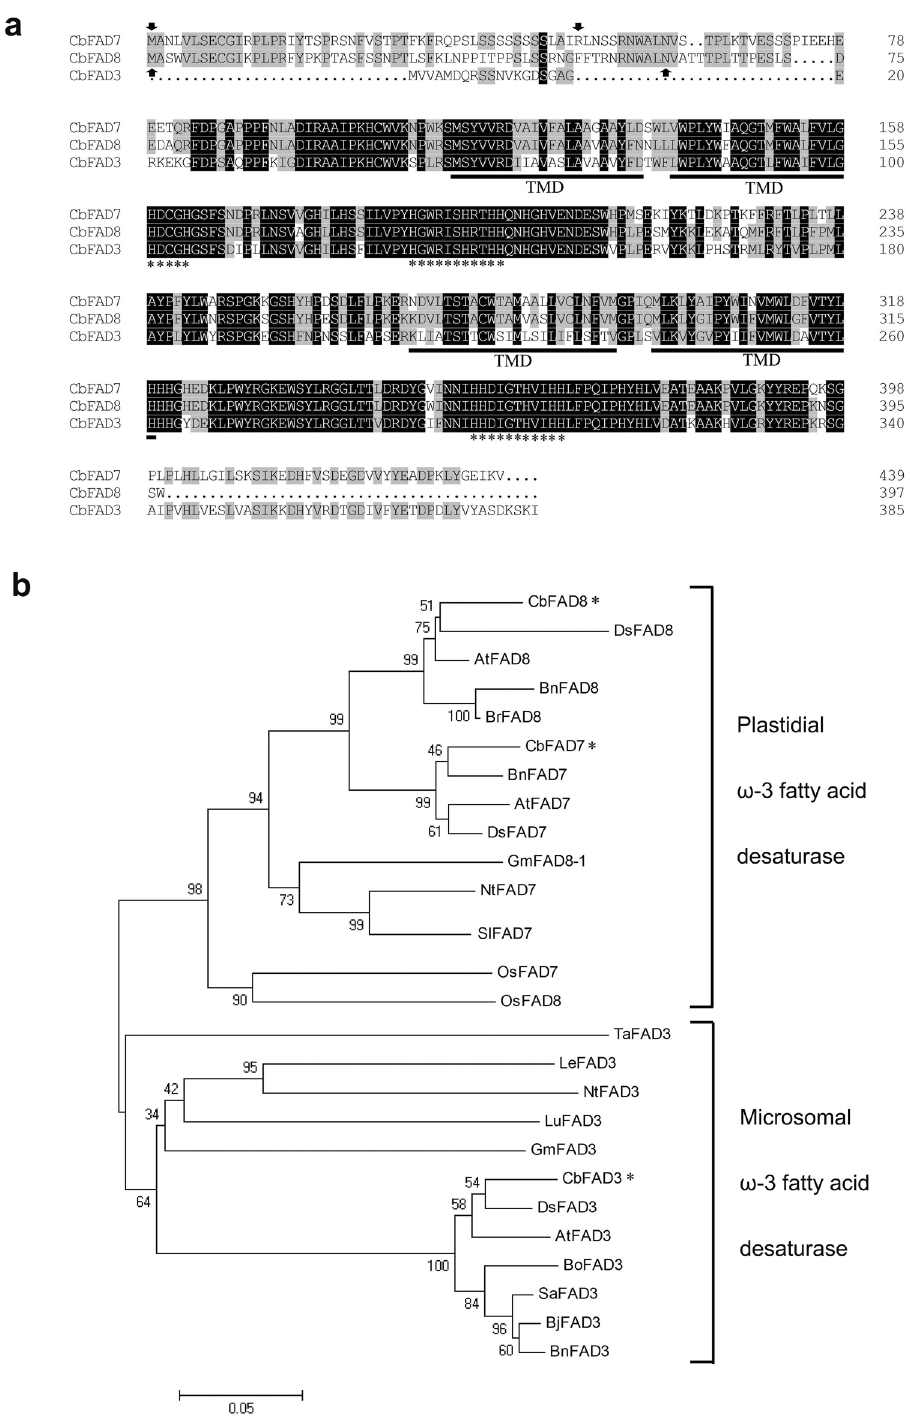
Figure 1. Analysis of the deduced amino acid sequences of C. bungeana ω-3 FADs. ( a ) Sequence comparison of CbFAD3, CbFAD7 and CbFAD8. Identical and similar residues are shown on a background of black and gray, respectively. The sequences of the putative chloroplast transit peptides of CbFAD7 and CbFAD8 are arrowed. The three conserved histidine clusters are indicated by asterisks, and the four transmembrane domains (TMD) are underlined. ( b ) Phylogenetic tree analysis of CbFAD3, CbFAD7 and CbFAD8. The positions of ω-3 CbFADs are asterisked. The accession number of different ω-3 FADs included in this analysis: Arabidopsis thaliana AtFAD3 (NP180559), Brassica juncea BjFAD3 (ADJ58019), Brassica napus BnFAD3 (NP001302640), Brassica oleracea BoFAD3 (AGH20189), Chorispora bungeana CbFAD3 (KM591203), Chorispora bungeana CbFAD7 (KY069282), Chorispora bungeana CbFAD8 (KY069283), Descurainia sophia DsFAD3 (ABK91879), Glycine max GmFAD3 (NP001237507), Lycopersicon esculentum LeFAD3 (ABX24525), Linum usitatissimum LuFAD3 (AFJ53089), Nicotiana tabacum NtFAD3 (P48626), Sinapis alba SaFAD3 (AHA05997), Triticum aestivum TaFAD3 (BAA28358), Arabidopsis thaliana AtFAD7 (P46310), Brassica napus BnFAD7 (ACS26170),